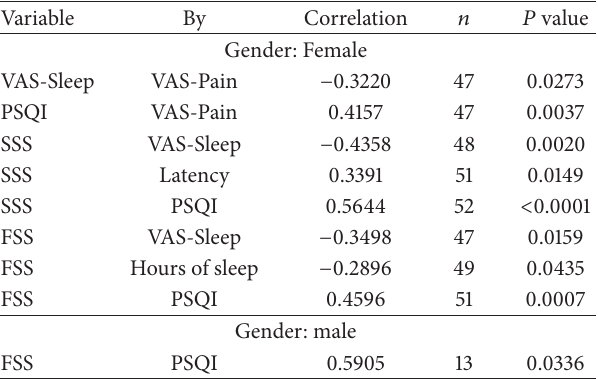
Table 1: Significant correlations of CTS and sleep parameters by gender.